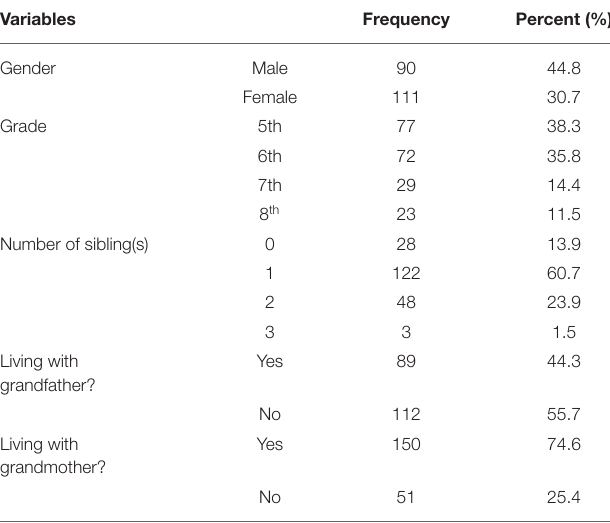
TABLE 1 | Demographic profile of participants ( N =